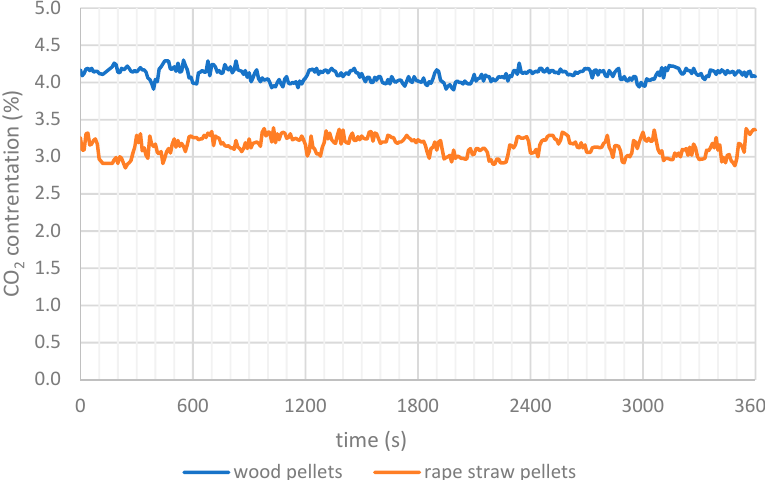
Figure 3. Time course of changes in CO 2 concentration for combustion tests of wood pellets and rape straw pellets.